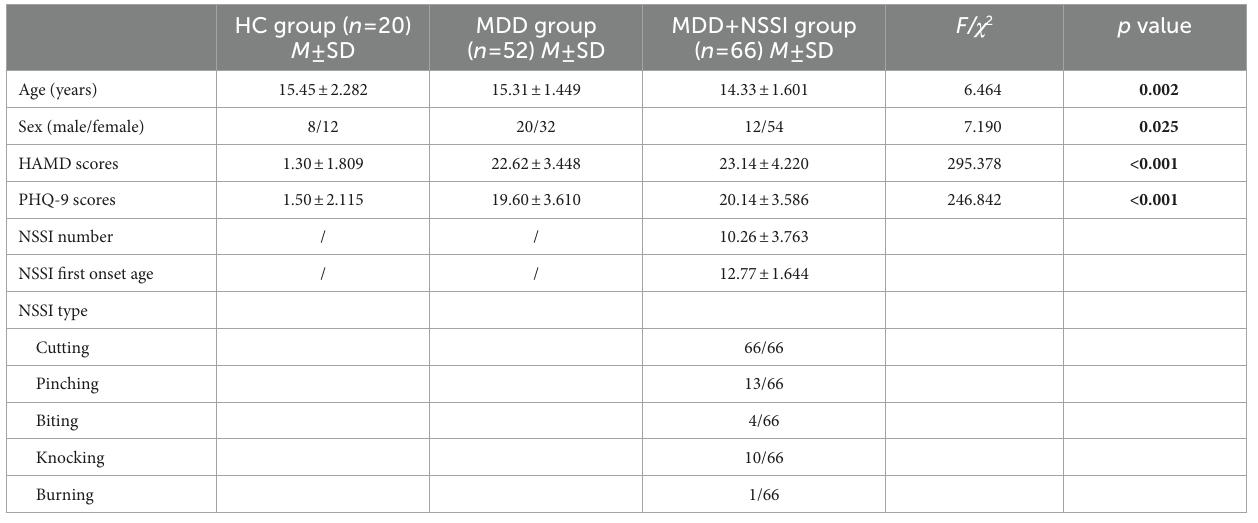
TABLE 1 Demographic and clinical characteristics of participants in the three groups at the baseline.